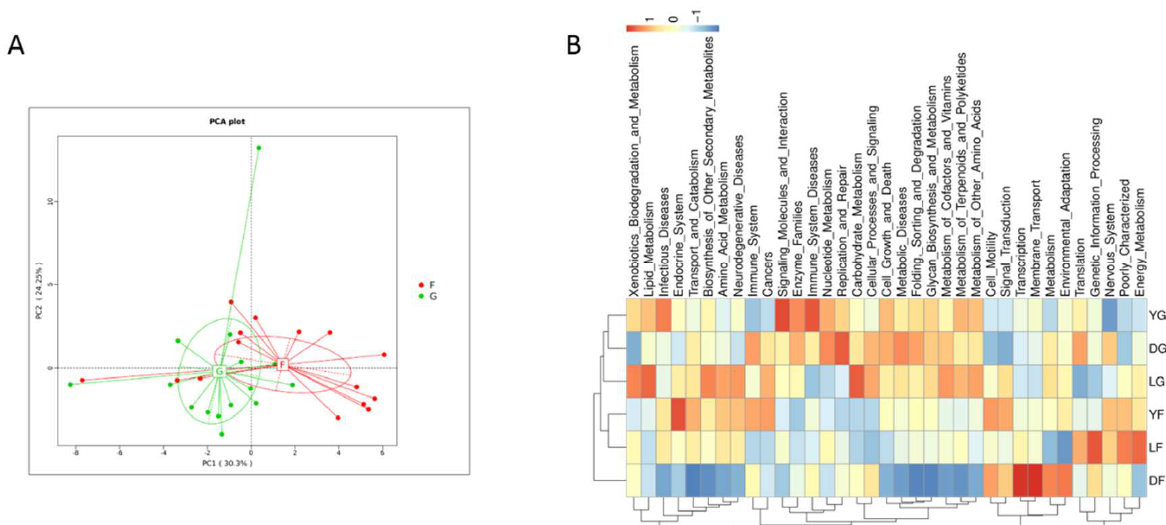
Figure 6. Predicted function of the gut microbiota of pigs of three different breeds at early and finishing growth stages based on KEGG pathway analysis using PICRUSt. ( A ) Principal component analysis of KEGG pathway abundance. G—early growth stage; F—finishing growth stage. ( B ) Clustering heatmap of KEGG pathway abundance in different sample group. DG—Duroc at early growth stage; LG—Landrace at early growth stage; YG—Yorkshire at early growth stage; DF— Duroc at finishing stage; LF—Landrace at finishing stage; YF—Yorkshire at finishing stage.